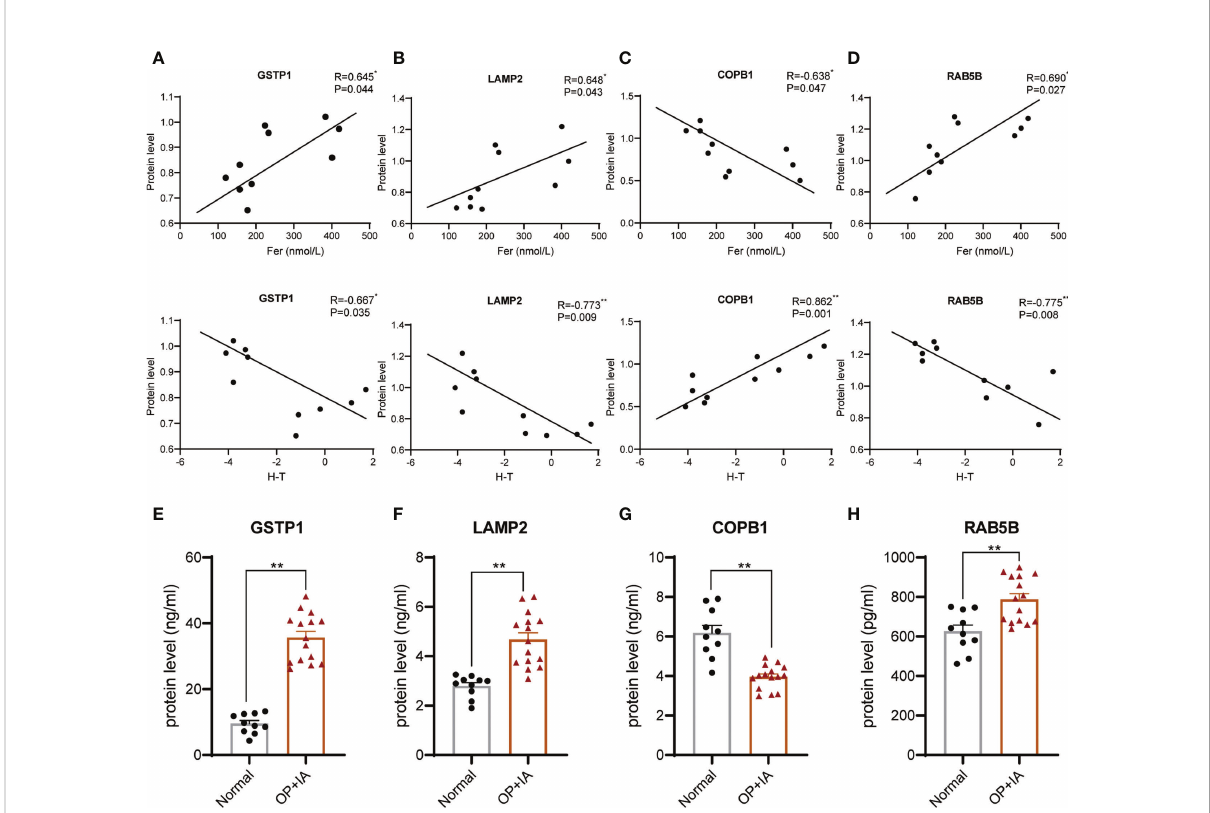
FIGURE 5 Core proteins were screened from the DEPs and validated in serum. (A-D) Correlation analysis of hip T score, serum ferritin and protein levels of core proteins, GSTP1 (A) , LAMP2 (B) , COPB1 (C) , and RAB5B (D) . (Pearson correlation analysis). (E-H) Serum protein levels of physical exam